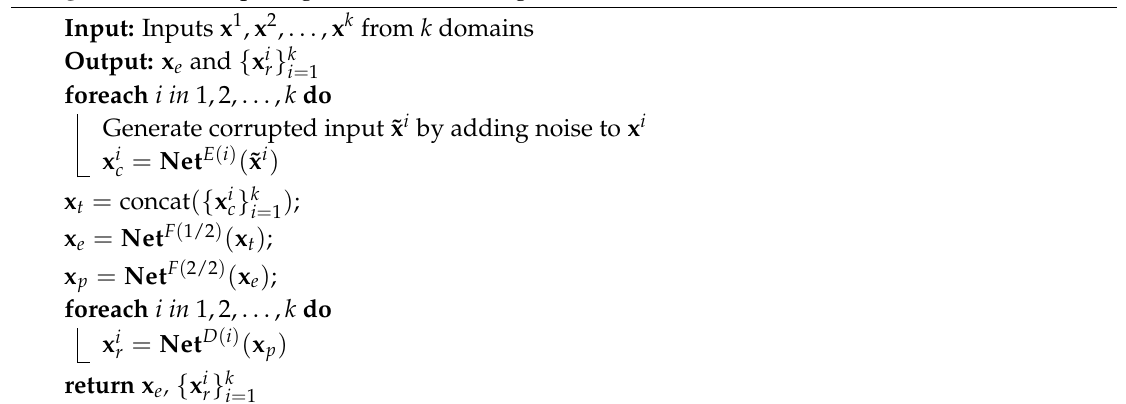
Algorithm 1: Computing x e and x r for a single